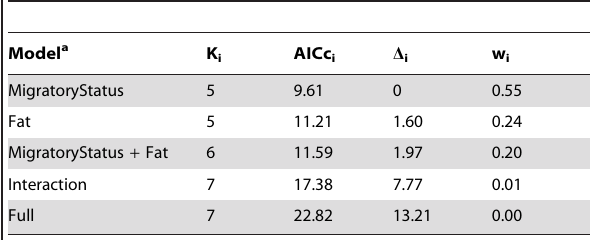
Table 1. Model selection results to predict plasma HMW adiponectin levels in the white-throated